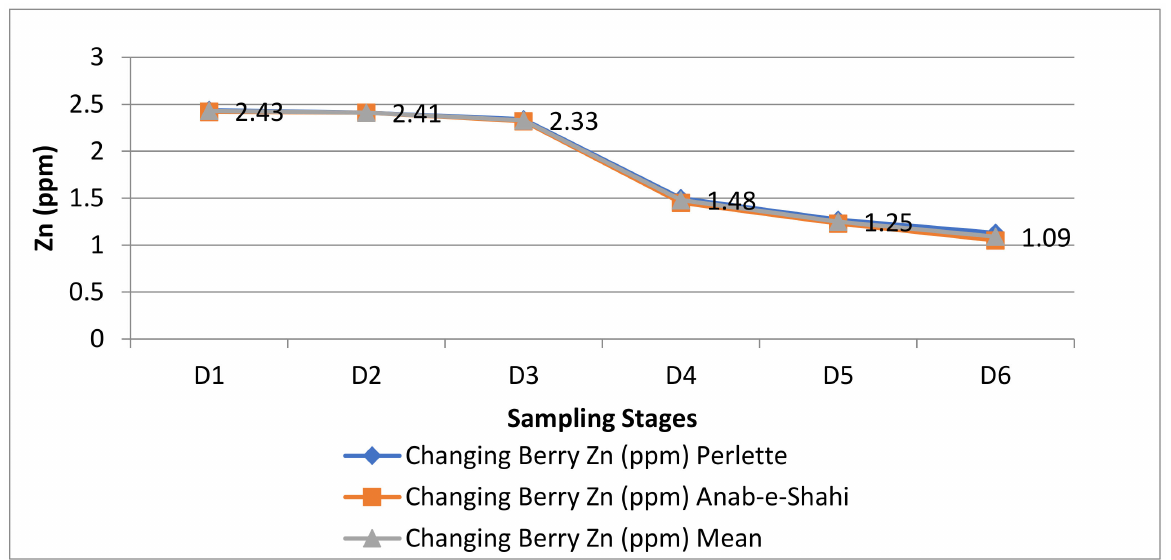
Figure 6. Dynamics of Zinc (ppm) during development of berries in grapes cv. Perlette and